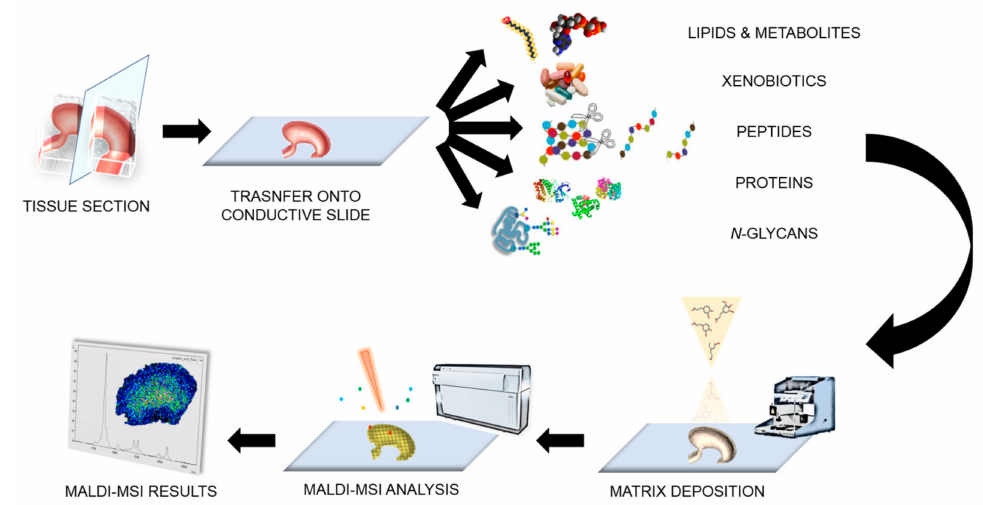
Figure 1. Illustration of the workflow for the matrix-assisted laser desorption/ionisation-mass spectrometry imaging (MALDI-MSI)